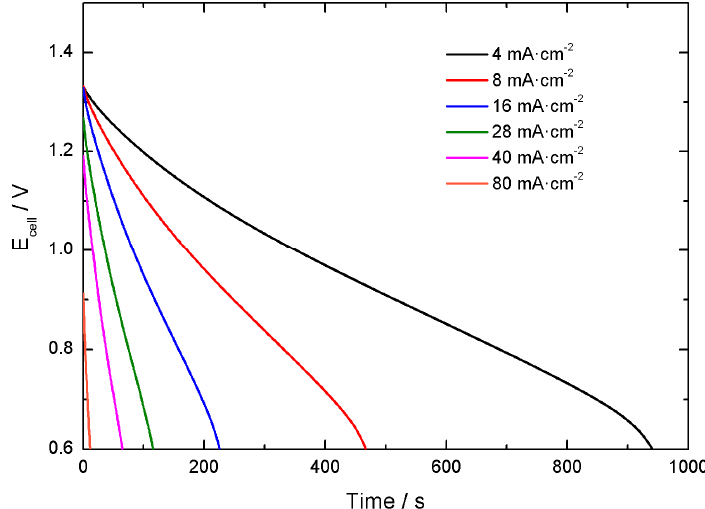
Figure 15. Galvanostatic discharge curves for different applied current densities in the 0.6 V to 1.4 V range for the coin cell.